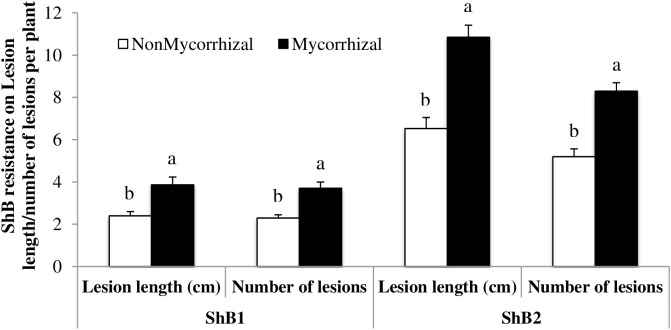
Rice sheath blight disease variables (lesion length and number of lesions) measured after inoculation with isolate LR172 of Rhizoctonia solani in mycorrhizal and nonmycorrhizal rice plants in greenhouse experiments in the summer 2013. NonMycorrhizal: rice seeds + sterilized AMF, Mycorrhizal: rice seeds + live AMF. Bars and lower case letters at the column head indicate that means differ significantly (LSD, P ≤ 0.05).